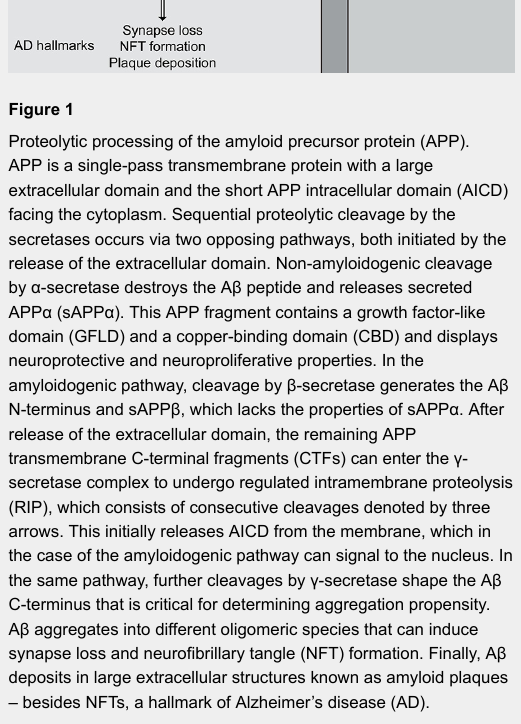
deposits in large extracellular structures known as amyloid plaques – besides NFTs, a hallmark of Alzheimer’s disease